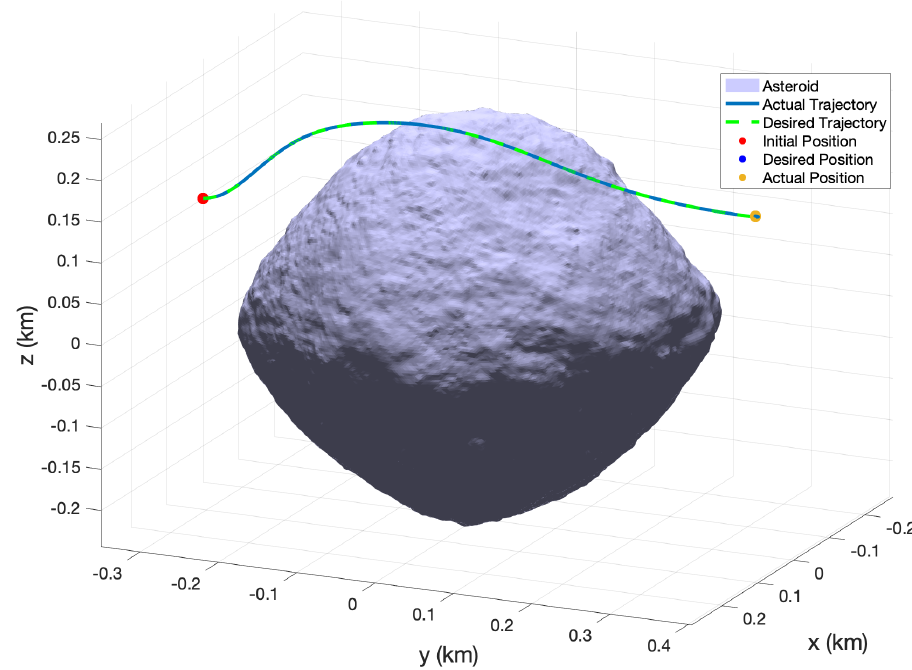
Figure 19. Trajectory of spacecraft around asteroid